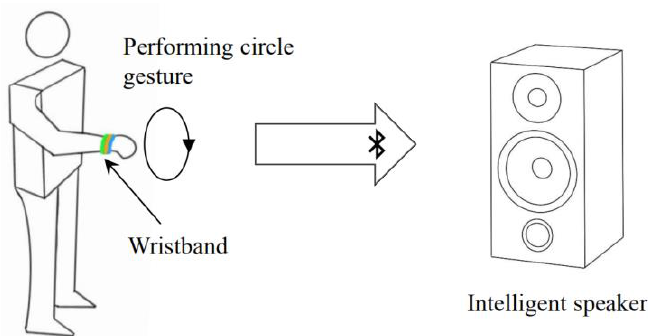
Figure 12. User wearing the wristband interacts with an intelligent speaker.